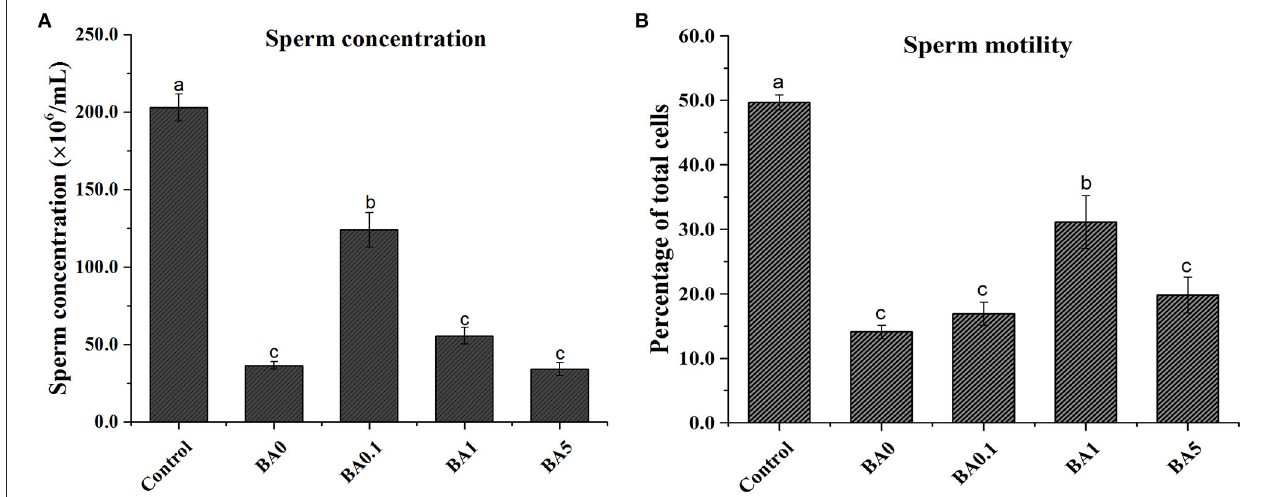
FIGURE 5 | Effect of the anthocyanin extract from red-fleshed apple on (A) sperm concentration and (B) sperm motility of mice after injection of busulfan. Within the samples, values with different letters (a, b, c) indicate significant differences ( p < 0.05).